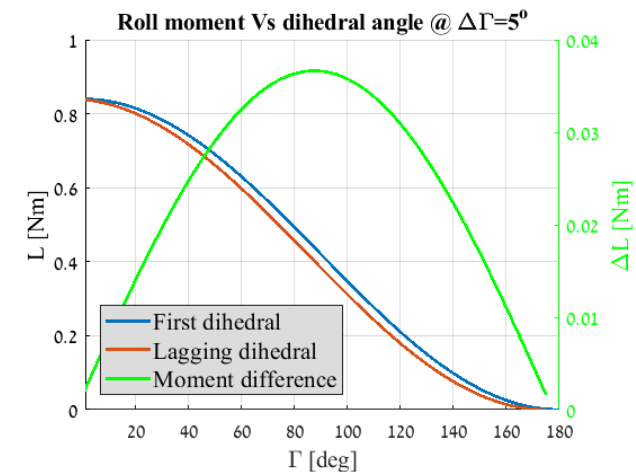
Figure 13. Roll moment of a folding wing and a second lagging wing vs. angle of